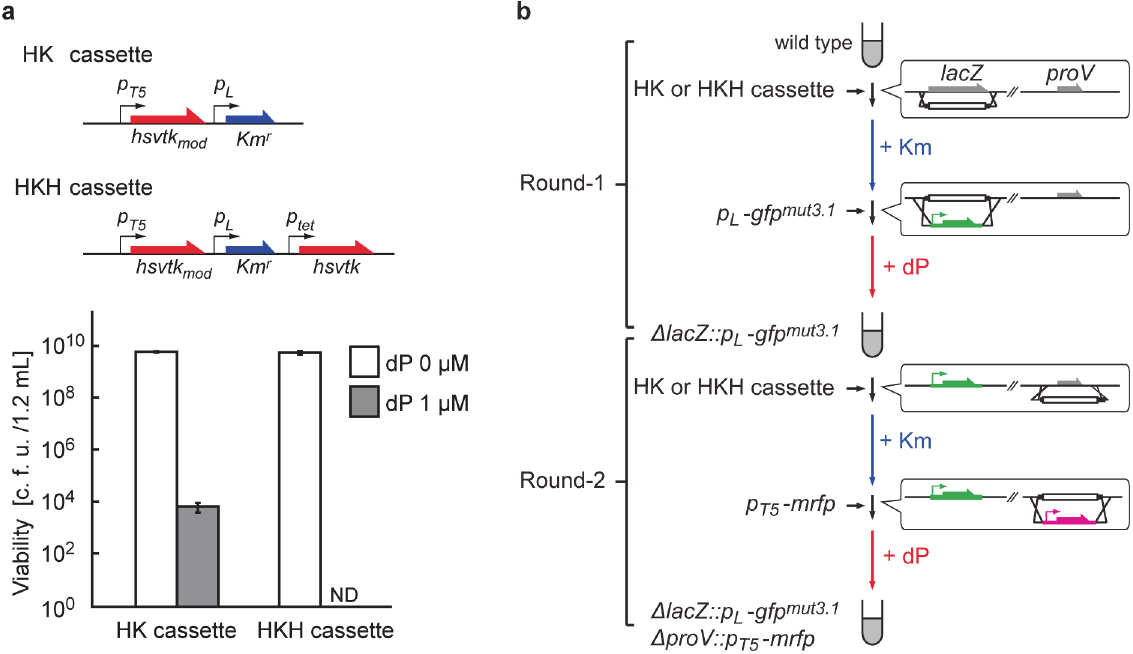
Fig 4. Duplication of hsvtk enables a two-round consecutive recombineering. (a) Killing efficiency of dP-selection against E . coli strain harboring a single hsvtk gene (HK cassette) or duplicated hsvtk (HKH cassette), ND: Not detected. The bar heights show the average of 3 samples, and error bars indicate the standard deviation. (b) The experimental workflow for a two-round consecutive recombineering: lacZ and proV loci were serially replaced with pL-gfp mut3 . 1 and pT5-mrfp cassette respectively using HK or HKH. All DNA cassettes used here were prepared with 40-bp homology arms to the individual target sites, except the step for replacing lacZ with pL-gfp mut3 . 1 cassette where 1-kbp homology arms were